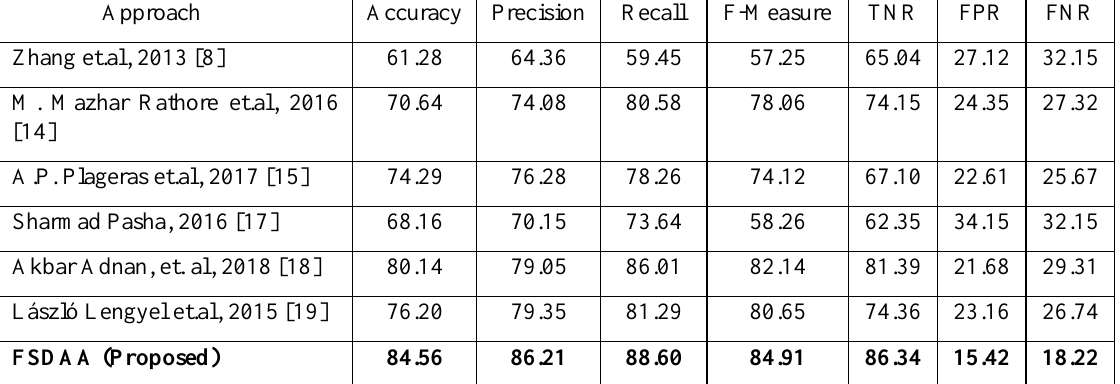
Table 1. Comparison of the various state of the art schemes with proposed FSDAA in percentage. Approach